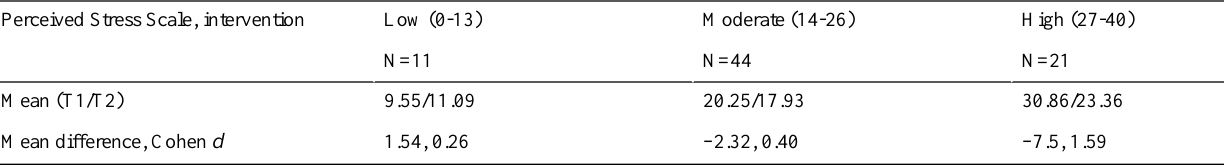
Table 13. Analysis of Perceived Stress Scale categories: intervention.